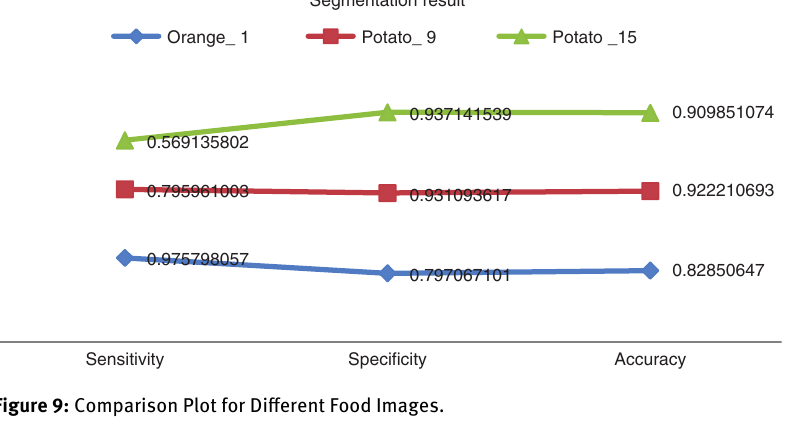
Figure 9: Comparison Plot for Different Food Images.